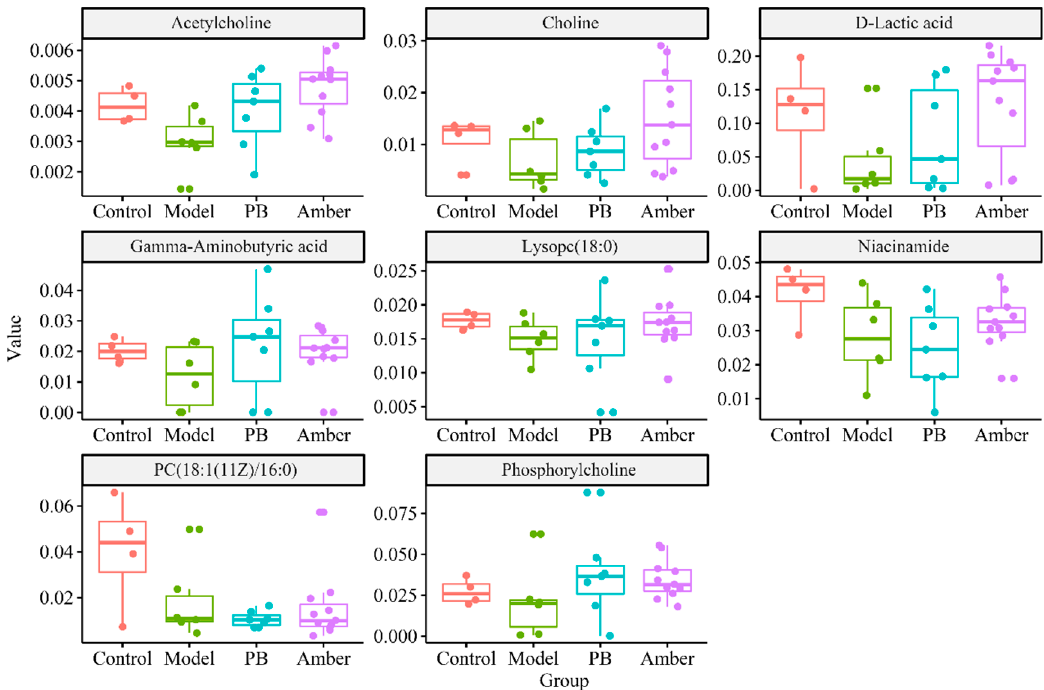
Figure 8. Boxplot of the metabolites associated with the four pathways in Figure 7.